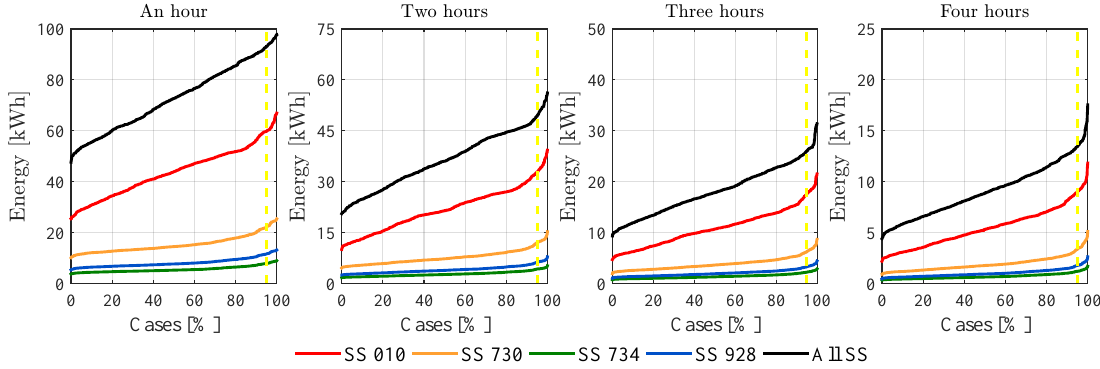
Figure 20. Probabilistic analysis of energy demand profiles in the PN. Table 10. Energy consumption (in 95% of cases) for each SS and according to the sector